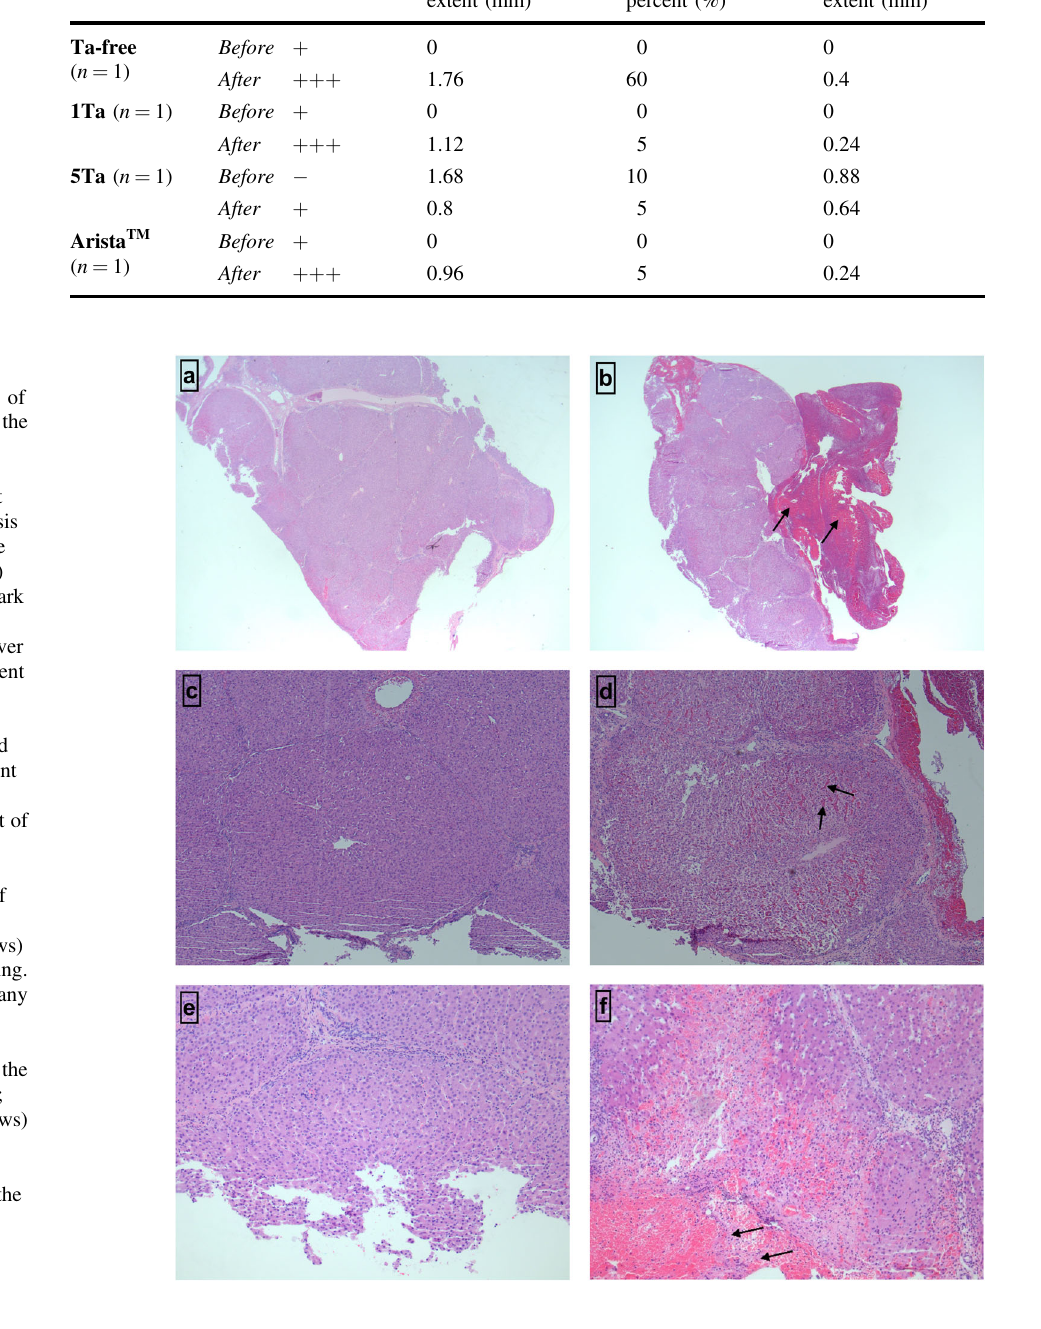
Table 4 Semi-quantitative histopathological grading of the liver tissue